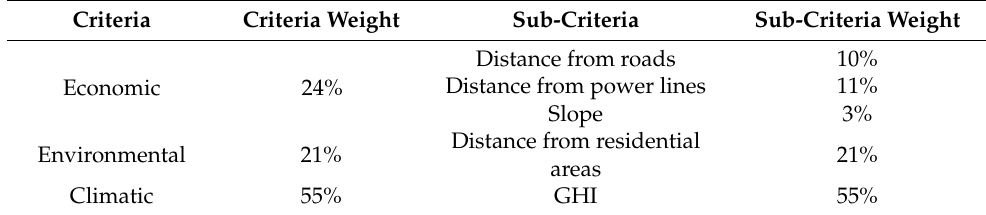
Table 6. Criteria and Sub-criteria AHP